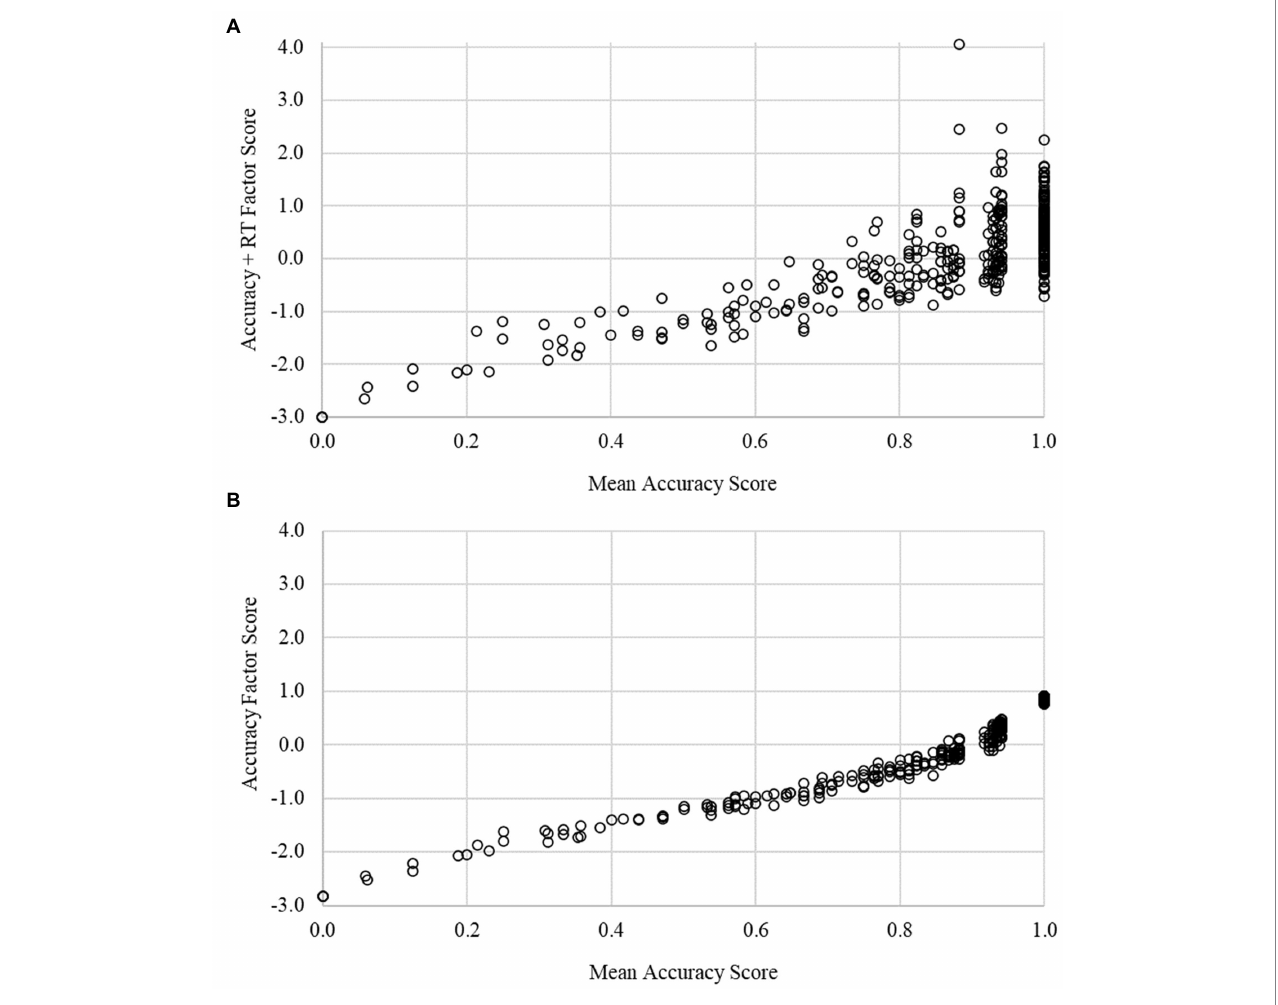
FIGURE 3 Score comparisons for the Silly Sounds Stroop task. This figure plots mean accuracy scores against the enriched ( A ) and accuracy ( B ) factor scores. Ceiling and near ceiling effects (mean accuracy scores >0.8) are mitigated using enriched, but not accuracy, factor scores.